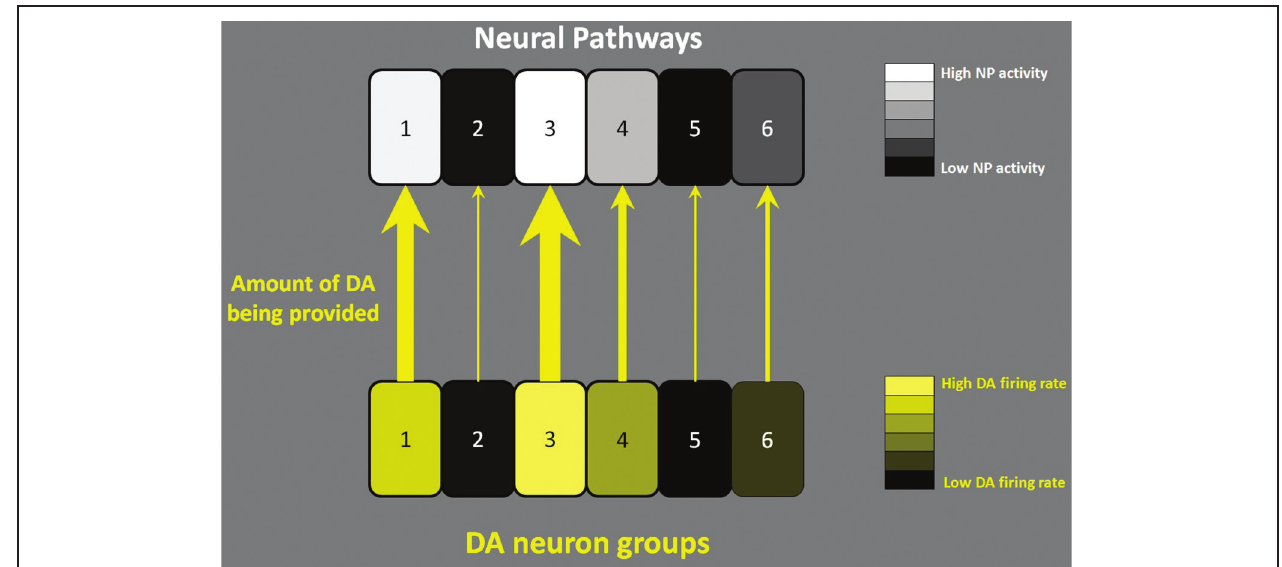
indicates the firing rate of DA neurons in different functional groups. The level of lightness of the squares in the top row indicates the activity level of the NPs. The thickness of the arrows indicates the amount of DA being provided to the target NPs; the thicker the arrows, the more DA provided. In the example above, NPs 1 and 3 are very active and are supported by the high level of DA coming from the corresponding DA neuron groups in the